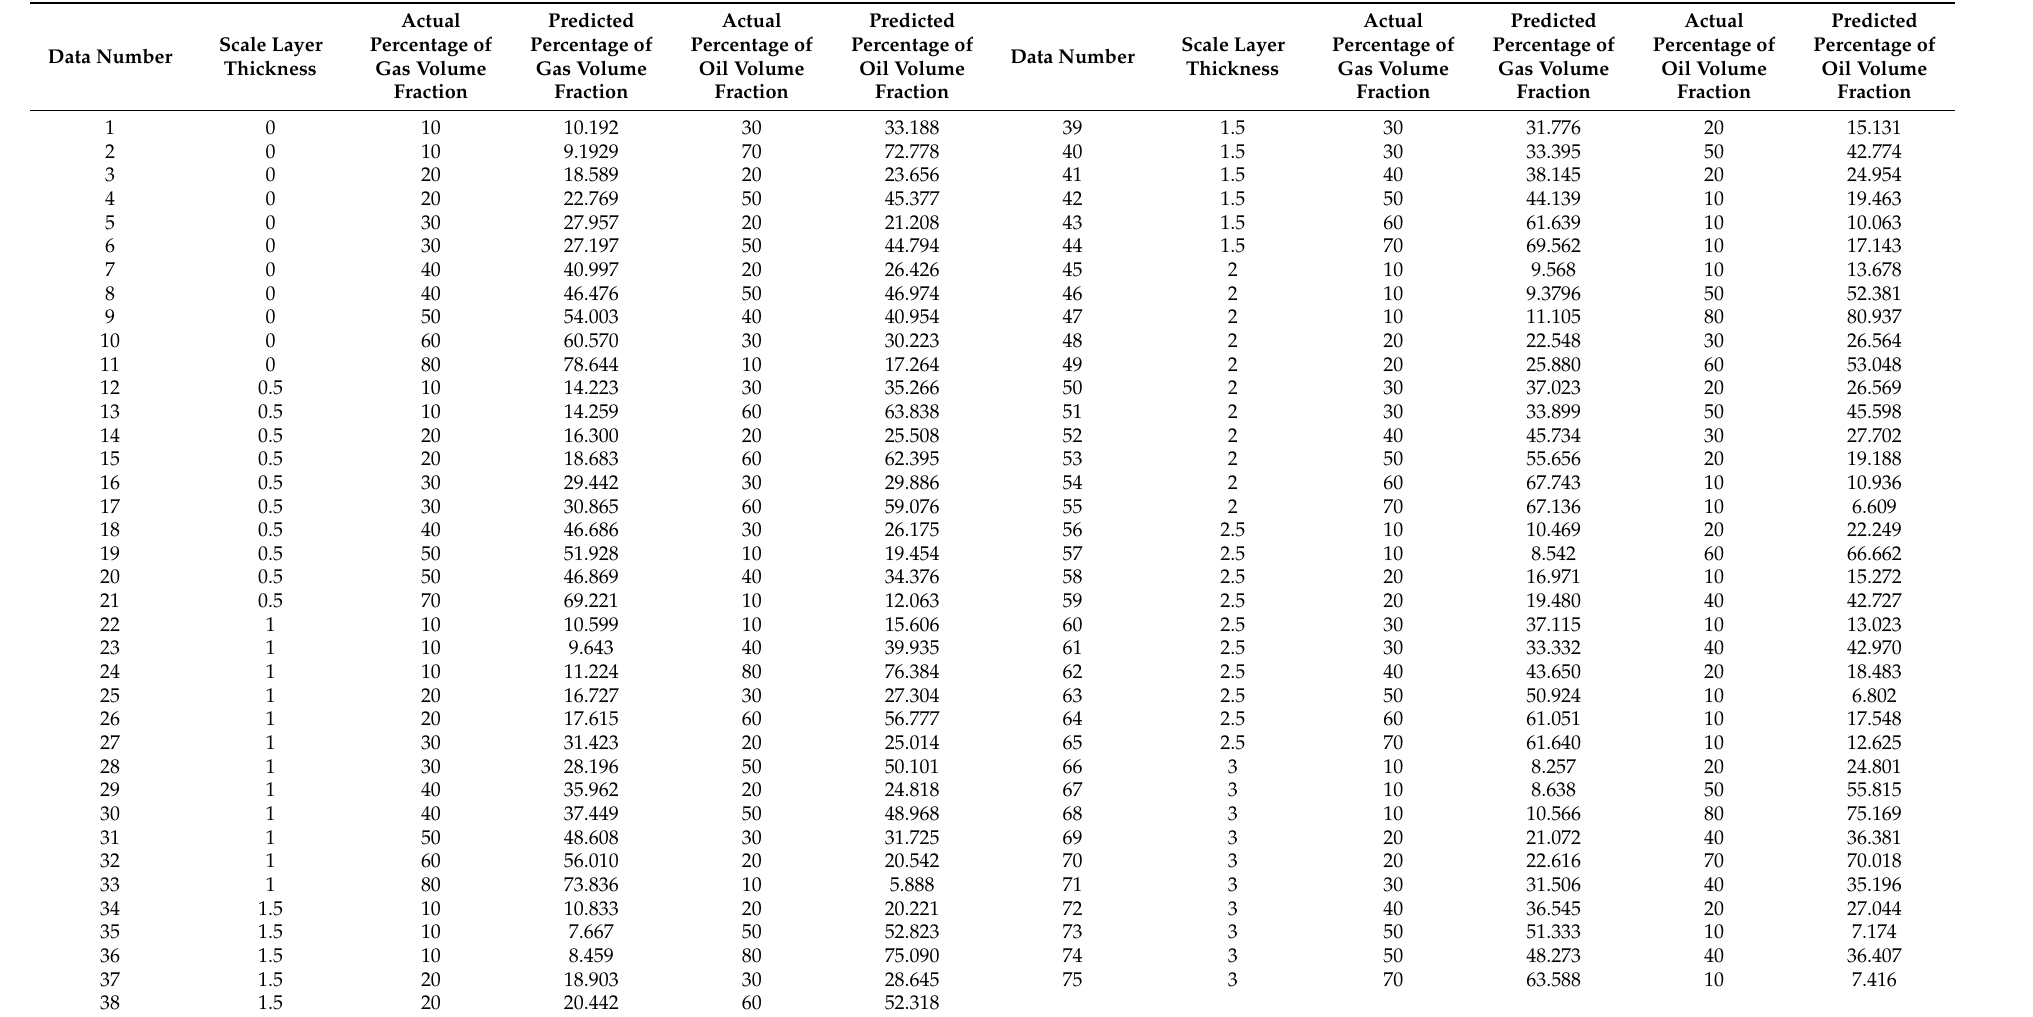
Table 1. The test data with predicted